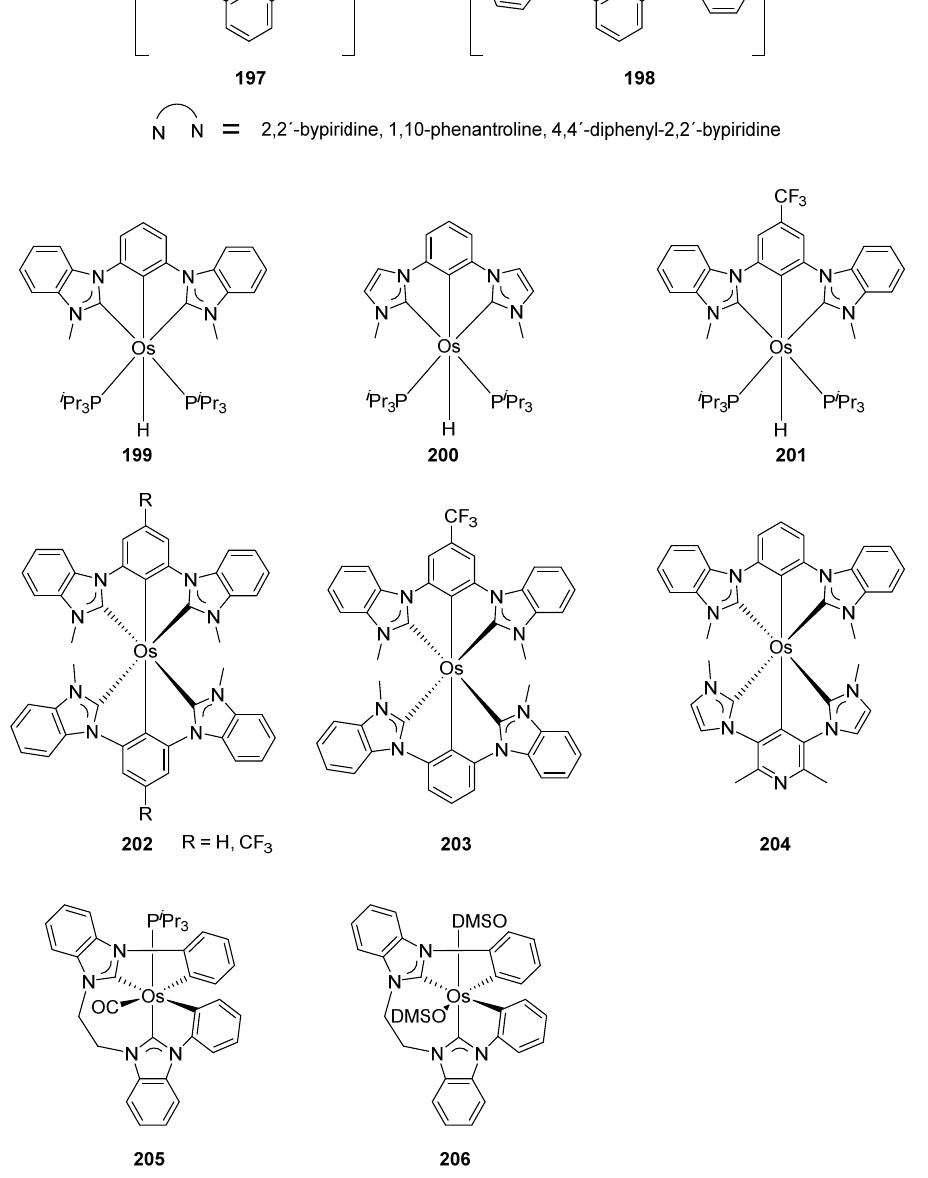
Figure 51. Luminescent carbene-based pincer complexes.